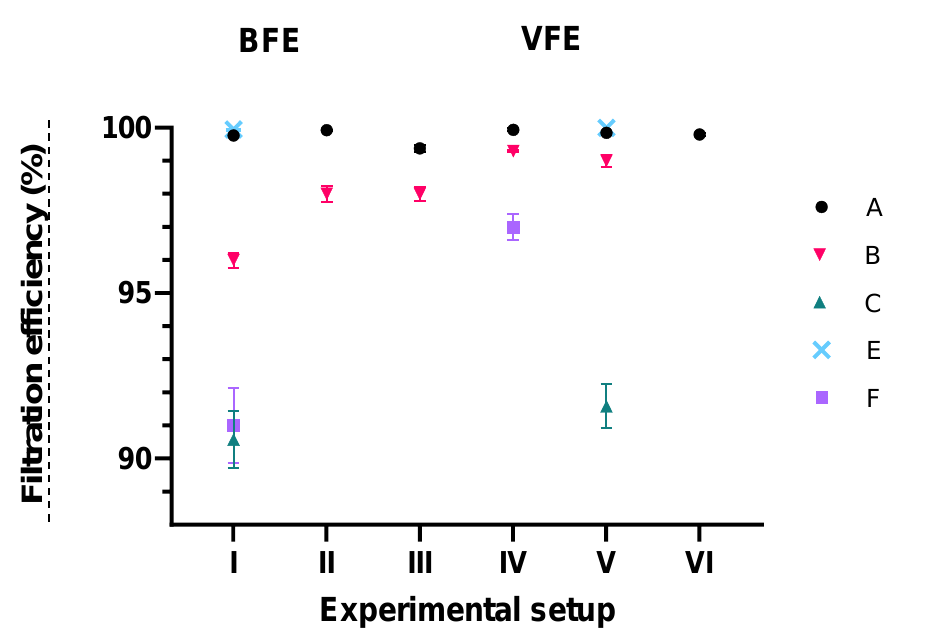
Figure 3. Average filtration efficiencies (bacterial, BFE, and viral, VFE) and their standard errors for each mask sample. BFE and VFE values were calculated from all subsamples of the same experimental setup for an individual mask sample. Results for mask D were not included on the graph due to their lower efficiency.